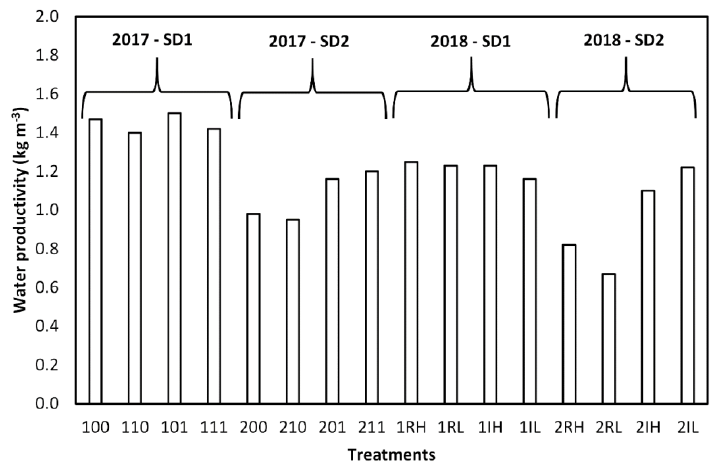
Figure 11. Water productivity (grain yield/evapotranspiration) of faba bean as affected by sowing time, watering regime, and sowing rate.